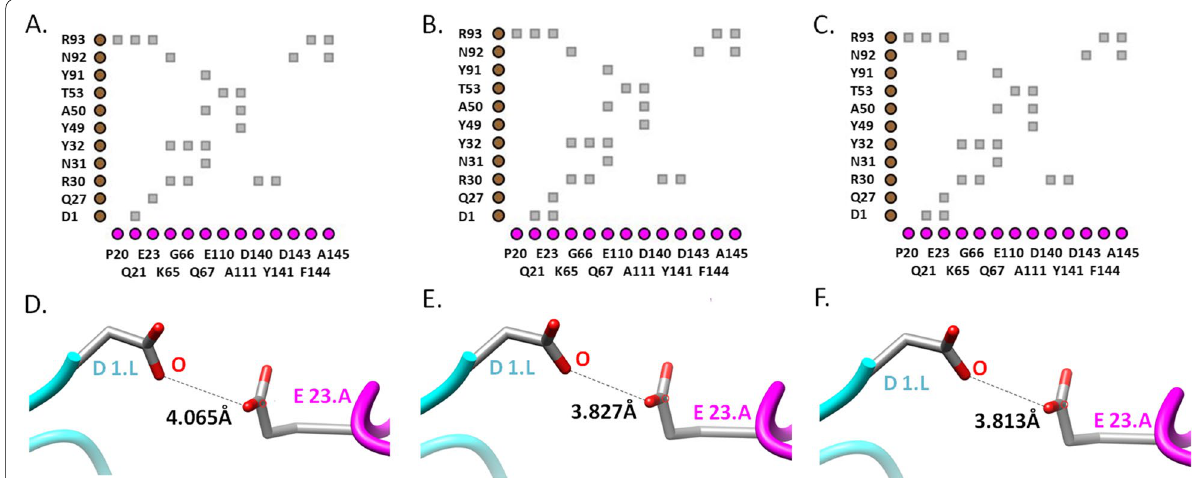
Fig. 1 Interactions between TNFA and adalimumab. 2D plots of interactions between the light chain of adalimumab and TNFA WT ( A ), TNFA G66C ( B ), and TNFA G66S ( C ) structures. Distance between TNFA Glu-23 and ADA Asp-1 in the L chain in wild-type ( D ), TNFA G66C , ( E ) and TNFA G66S ( F ) variant structures. In the 2D interaction plots TNFA residues are shown along the horizontal axis and adalimumab light chain residues are delineated along the vertical axis. Grey- contacts/interactions (within 4